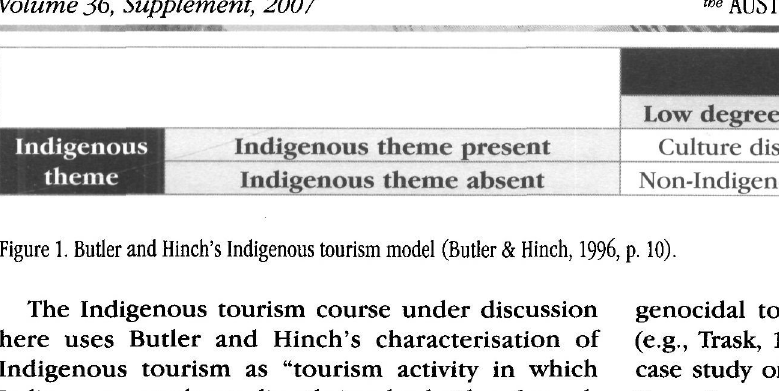
Figure 1. Butler and Hinch's Indigenous tourism model (Butler & Hinch, 1996, p.